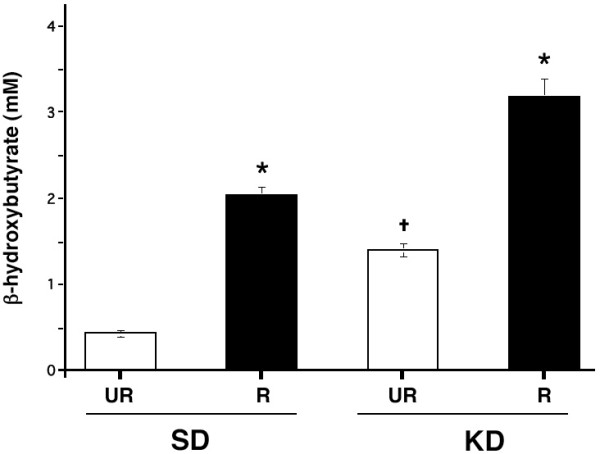
Influence of diet on plasma β-hydroxybutyrate levels in adult EL mice. Asterisks indicate that the plasma β-hydroxybutyrate levels were significantly higher (p < 0.001) in the R-fed groups than in their respective UR-fed groups. The cross indicates that the plasma β-hydroxybutyrate levels were significantly higher (p < 0.001) in the KD-UR group than in the SD-UR group. Other conditions are as in Figures 1 and 2.